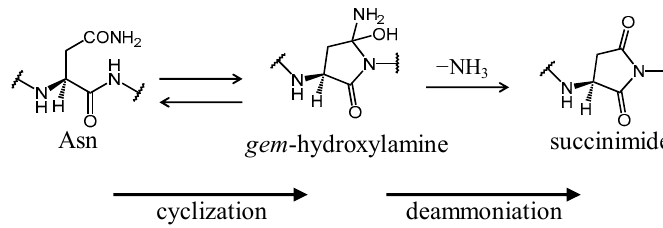
Figure 2. Proposed two-step succinimide formation pathway of Asn residues.